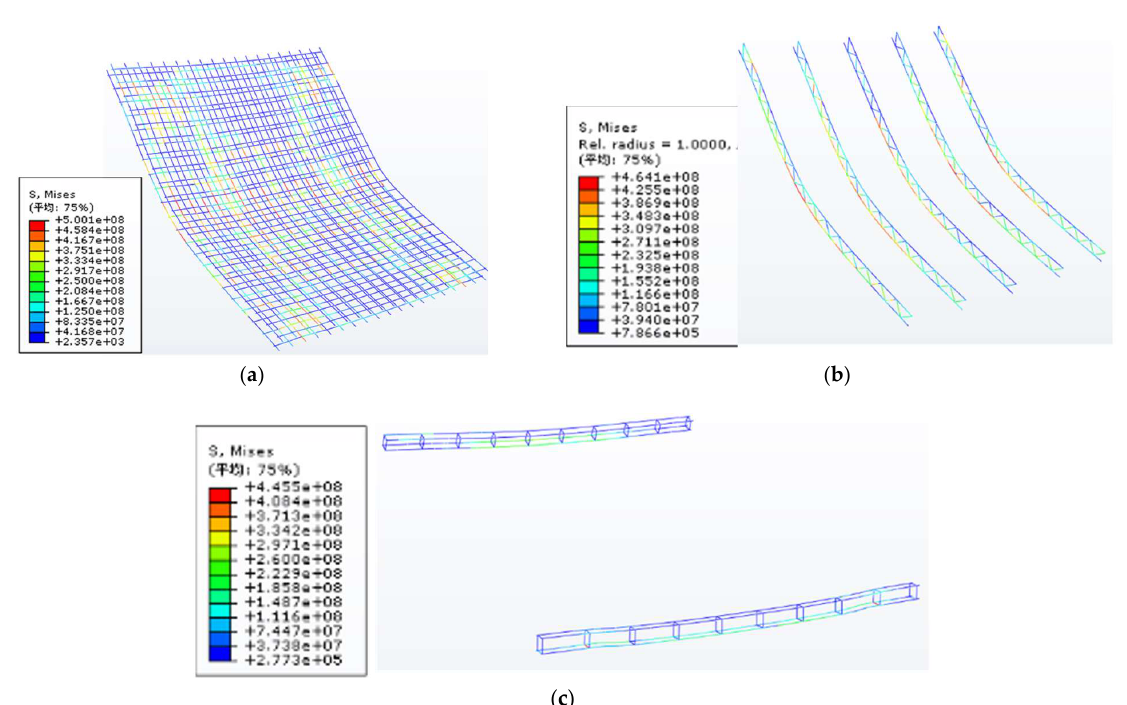
Figure 14. Stress distributions of specimen WP. ( a ) Stress of reinforcement wire. ( b ) Stress of steel truss parallel to the span. ( c ) Mises stress contour plots of steel truss perpendicular to the span. The non-English term ‘ 平均 ’ means ‘Average’.